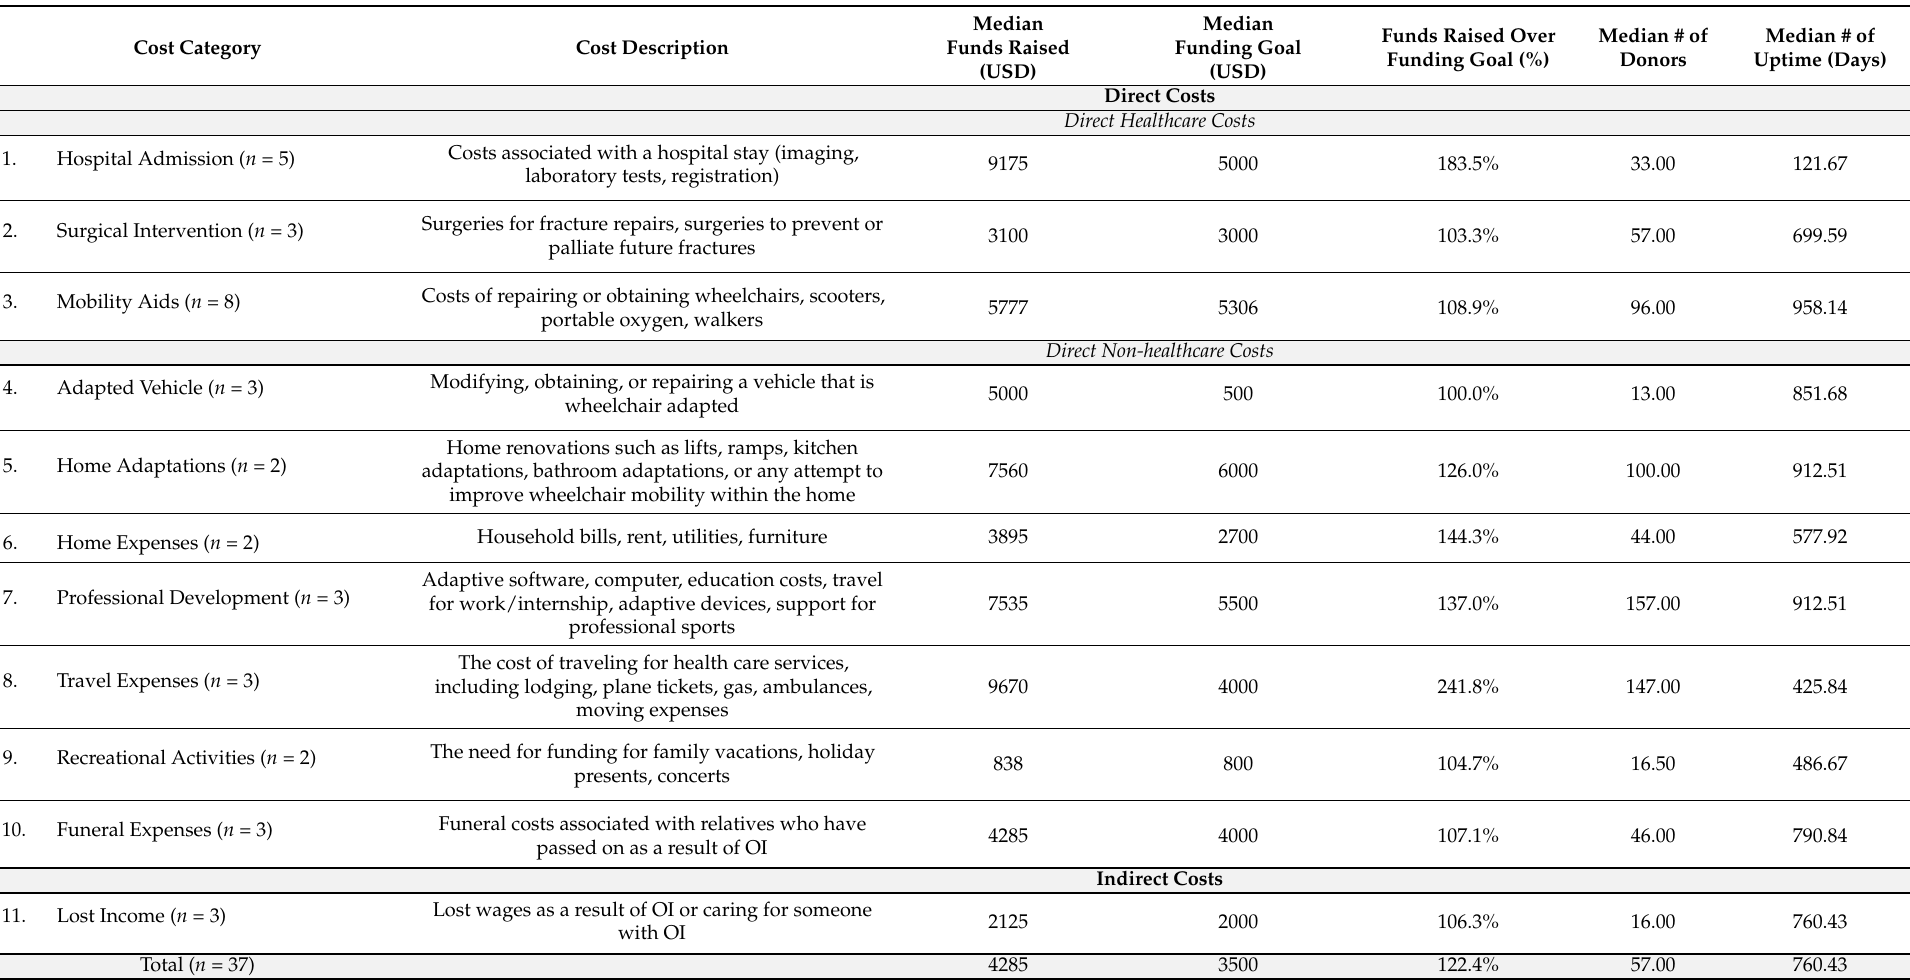
Table 2. Summary of the 37 GoFundMe ® Web profiles whose Campaign Exceeded the Funding Goal Raising Funds for 11 of the 19 Cost Categories Associated with Osteogenesis